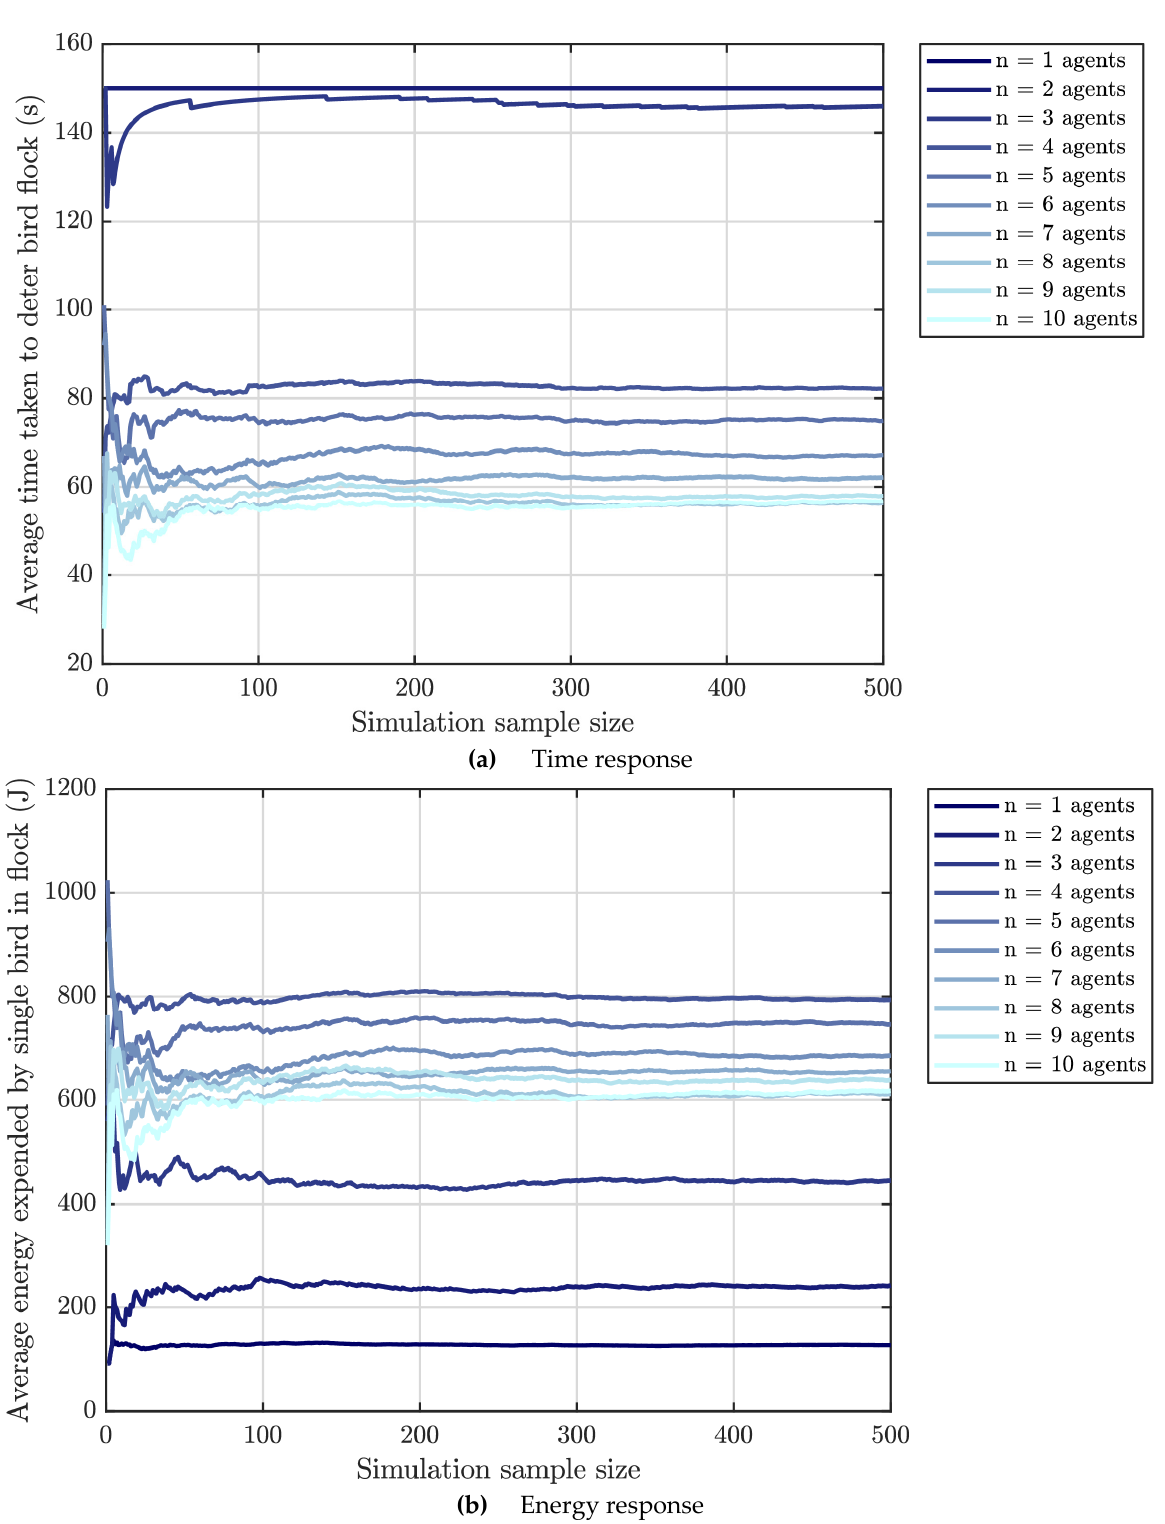
Figure A1. Simulation convergence study for ( a ) time response and ( b ) energy expenditure, with varied agent number but fixed tether radius at R T = 14 m. As simulation sample size increases, more values are being used to calculate the mean; every data point represents the running average of all preceding simulations from a minimum of 1 simulation up to a maximum of 500 simulations.